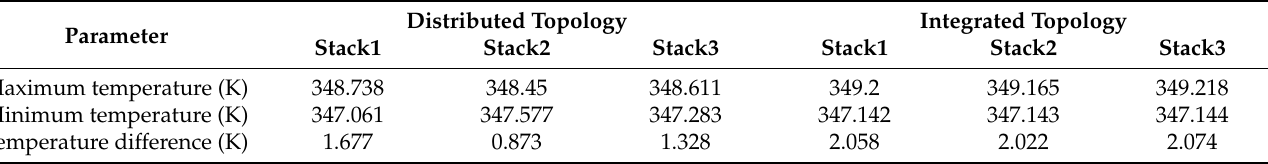
Table 3. The detailed comparison of the two topologies under variable working